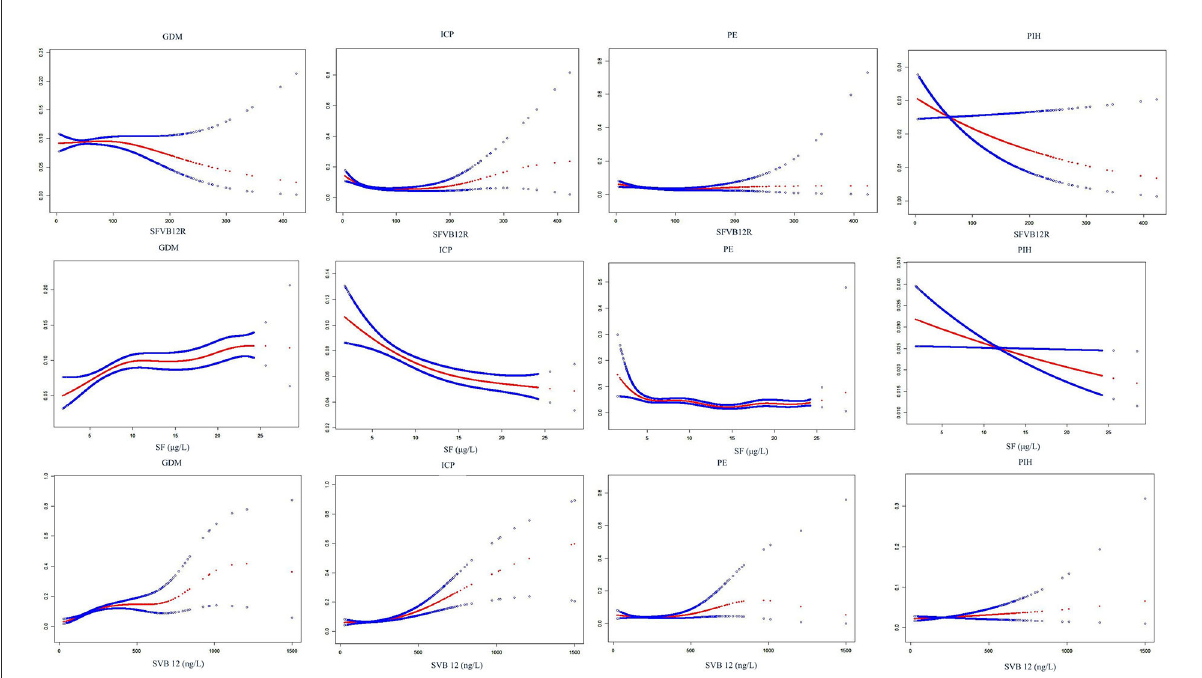
FIGURE2 Smooth curve fitting analysis of SF, SVB12, and SFVB12R with the risk of pregnancy complications. For SFVB12R vs. pregnancy complications, adjusting for maternal age, BMI, gravidity, parity; for SF vs. pregnancy complications, additionally adjusting for SVB12; for SVB12 vs. pregnancy complications, additionally adjusting for SF. SFVB12R, serum folate to vitamin B12 ratio; SF, serum folate, SVB12, serum vitamin B12; GDM, gestational diabetes mellitus; ICP, intrahepatic cholestasis of pregnancy; PE, pre-eclampsia; PIH, pregnancy induced